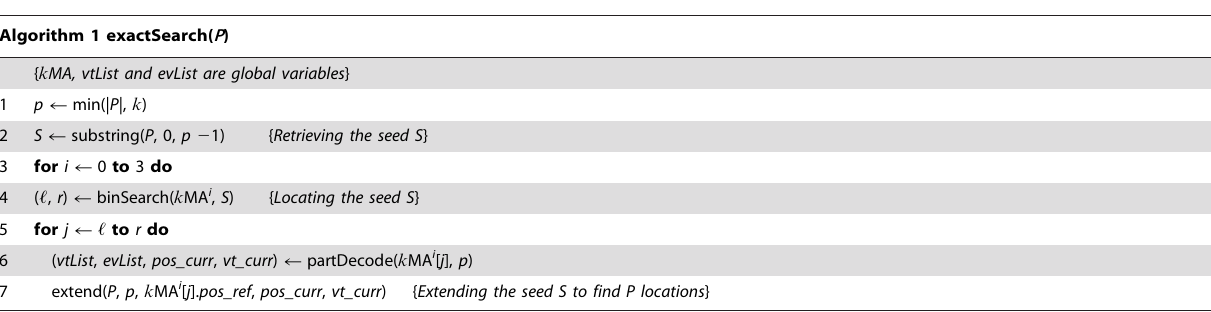
Table 1. Pseudocode of the basic search algorithm.